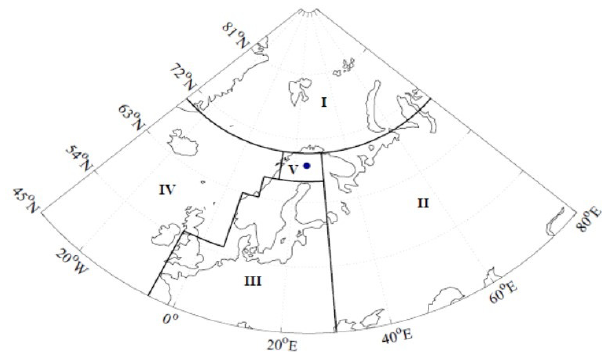
Figure 3. Map of the air mass regions: I (Arctic), II (Eastern), III (Southern), IV (Western) and V (Local). Figure was adopted from Asmi et al.